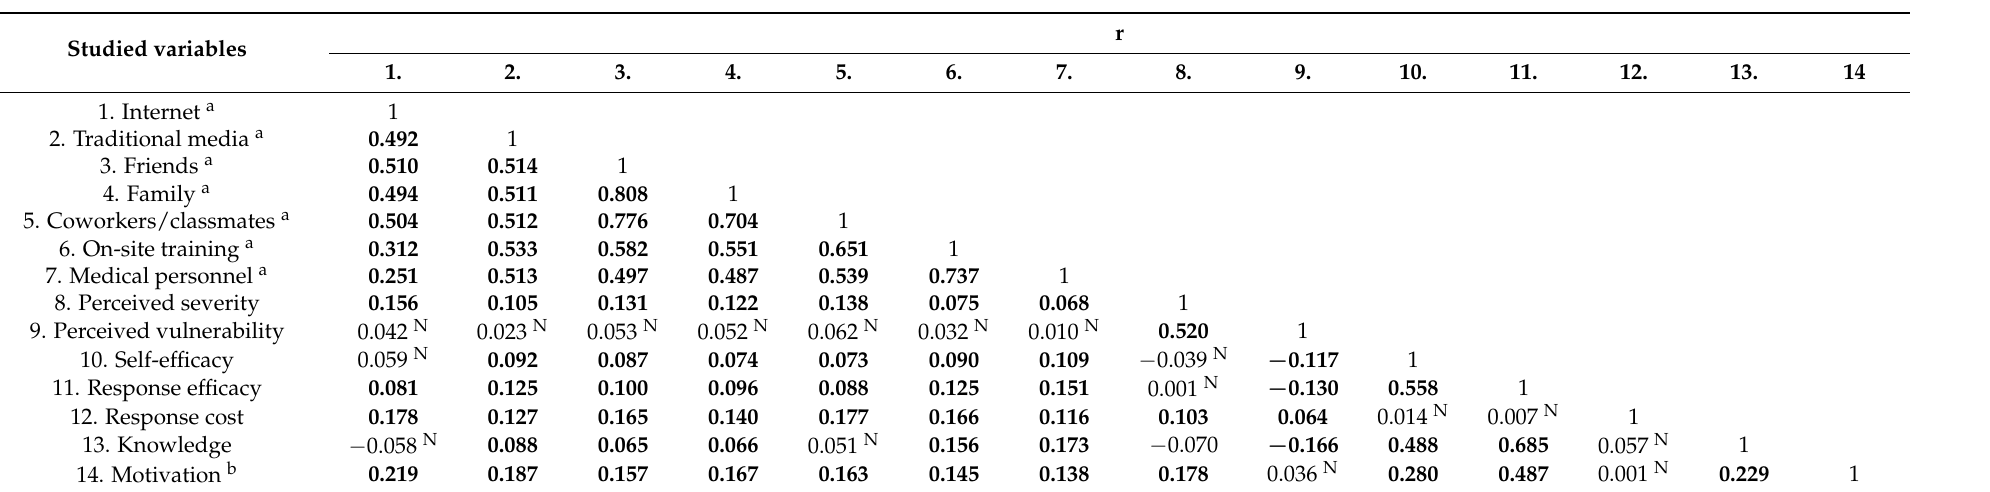
Table 3. Pearson correlation in the associations between studied variables.